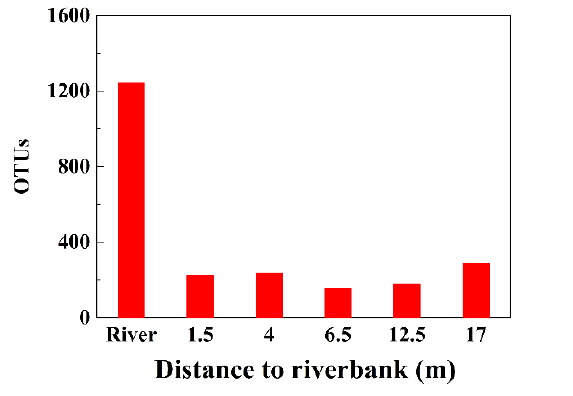
Figure 4. Microbial abundance and diversity.